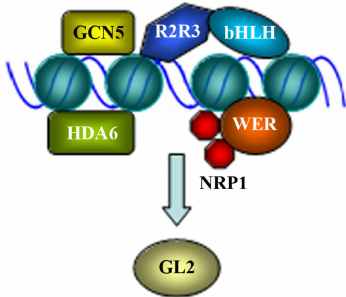
Figure 2. Regulation of GL2 expression. Several di ff erent regulators are involved in the regulation of GL2 , and the expression of GL2 may be regulated at di ff erent ways. (i) Interaction of R2R3 MYB protein GL1 or WER and bHLH protein GL3 or EGL3 are required and su ffi cient to activate GL2 , and concurrent binding of the R2R3 MYB and bHLH proteins to the promoter region of GL2 is required for the activation. (ii) Dimer of histone chaperone NAP1-RELATED PROTEIN1 (NRP1) interacts with WER and bind to the promoter region of GL2 to regulate its expression. NRP2 is also involved in the regulation of GL2 . (iii) Histone deacetylase HDA6 binds directly to the promoter region of GL2 to regulate its expression. (iv) Histone acetyltransferase GCN5 binds directly to the promoter region of GL2 to regulate its expression. It is unclear if HDA6 and GCN5 regulated expression of GL2 is depend on the R2R3 MYB proteins GL1 or WER and the bHLH proteins GL3 or EGL3, and if the regulators function in sequential to regulate the expression of GL2